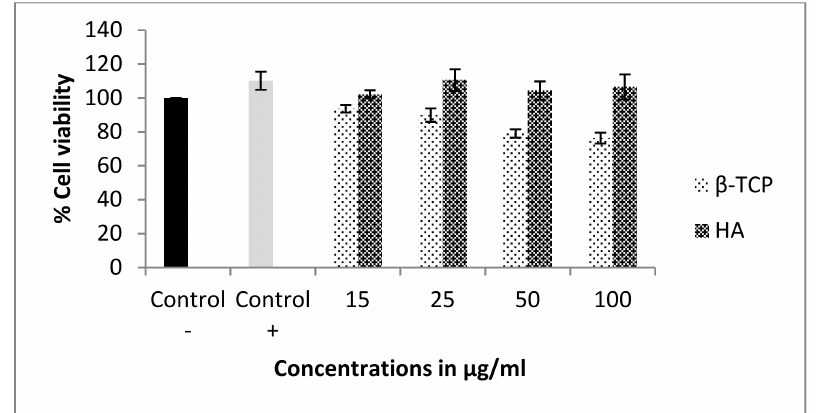
Figure 5. The effect of β -TCP and HA on MG-63 cell viability. Cells were treated with 15, 25, 50 and 100 µ g/mL of each bone graft. Two control groups were used, control-maintained at 1% FBS and control + maintained at 10% FBS. The results are mean ± standard error (SE) of three independent experiments.